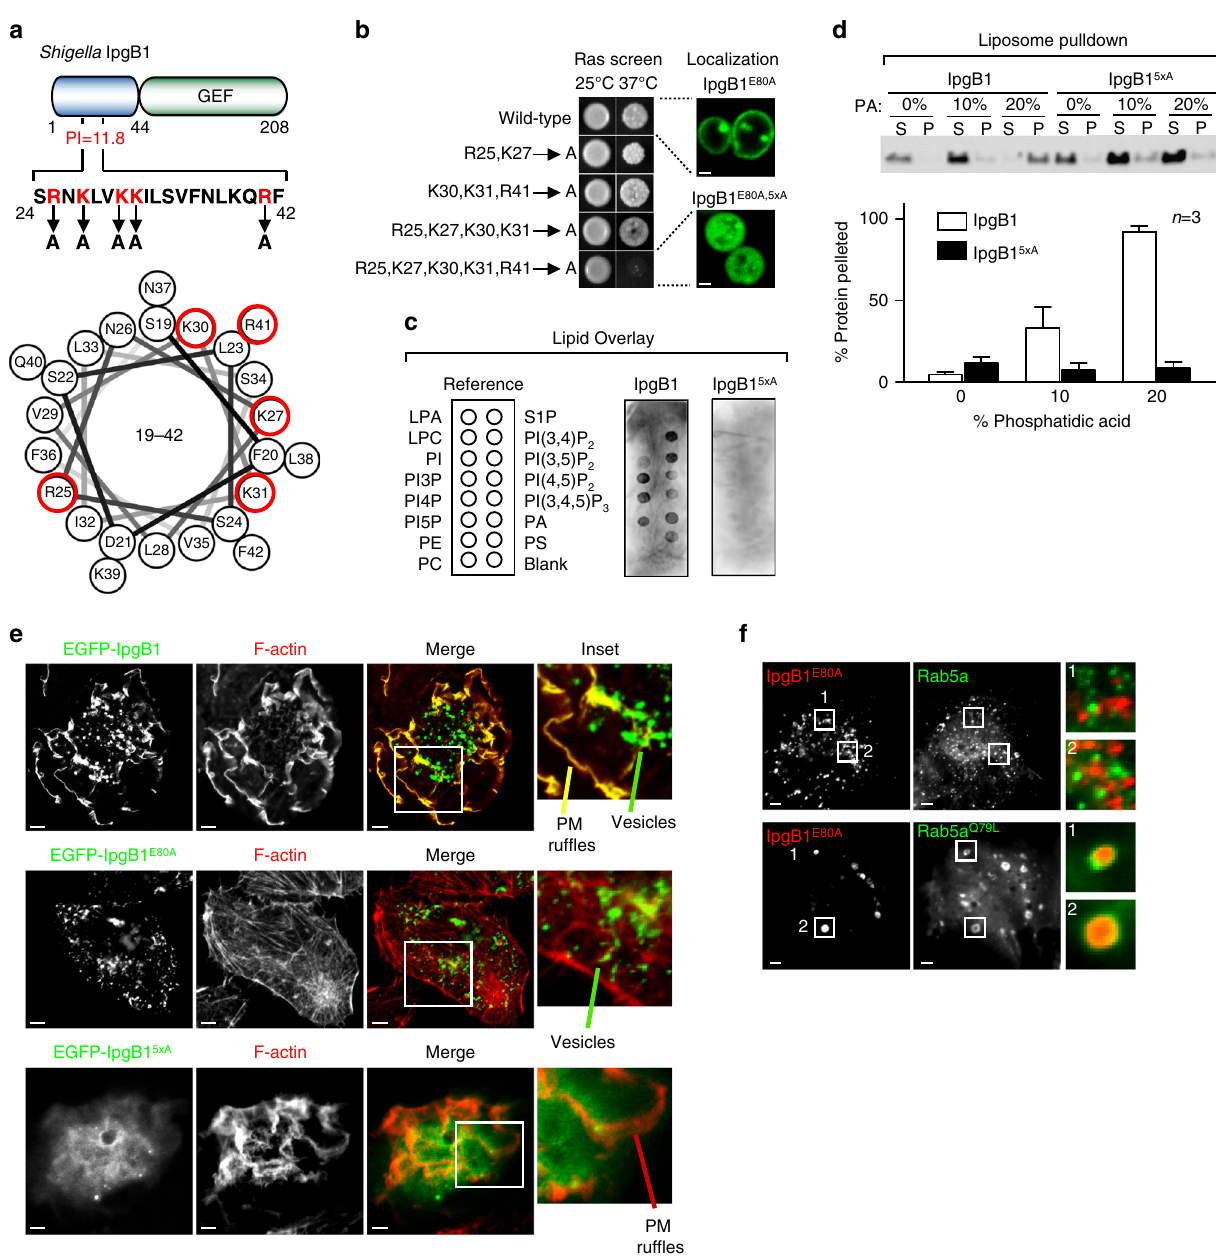
Fig. 7 IpgB1 polybasic domain confers phospholipid binding and membrane targeting. a Cartoon diagram of the IpgB1 protein depicting the C-terminal GEF domain and N-terminal polybasic domain. In addition, a helical wheel projection of amino acids 19 – 42 is shown below with amino acids targeted